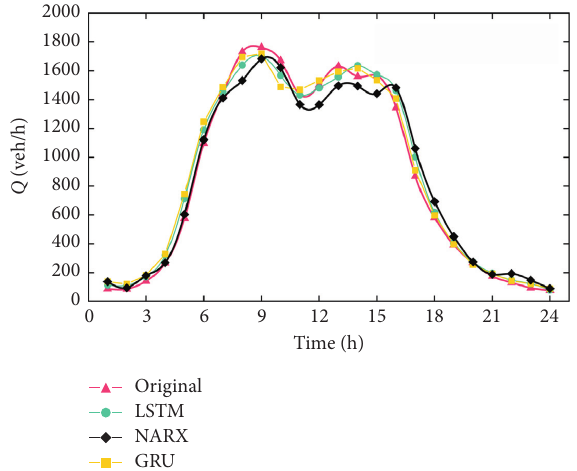
Figure 12: Comparison of prediction